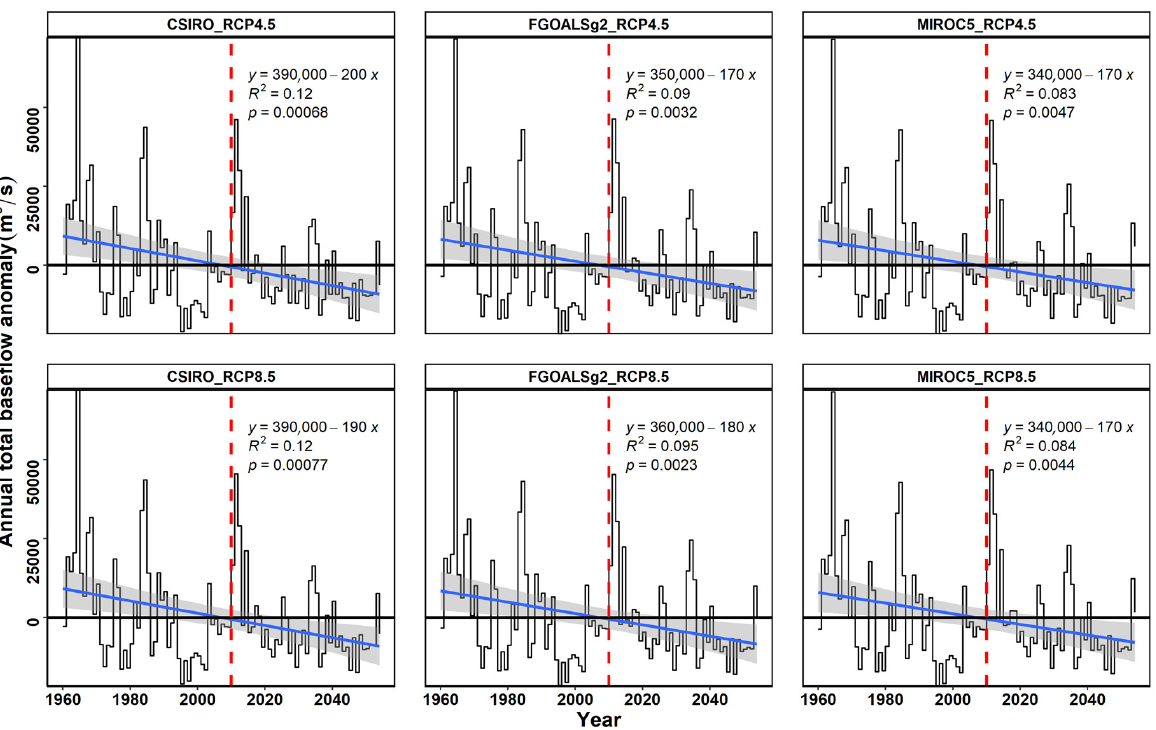
Figure 7. Baseflow anomaly plot from the entire streamflow time series in three models and two scenarios. The blue line is the linear regression line. The red vertical dashed line divides the time series into historical and future periods.